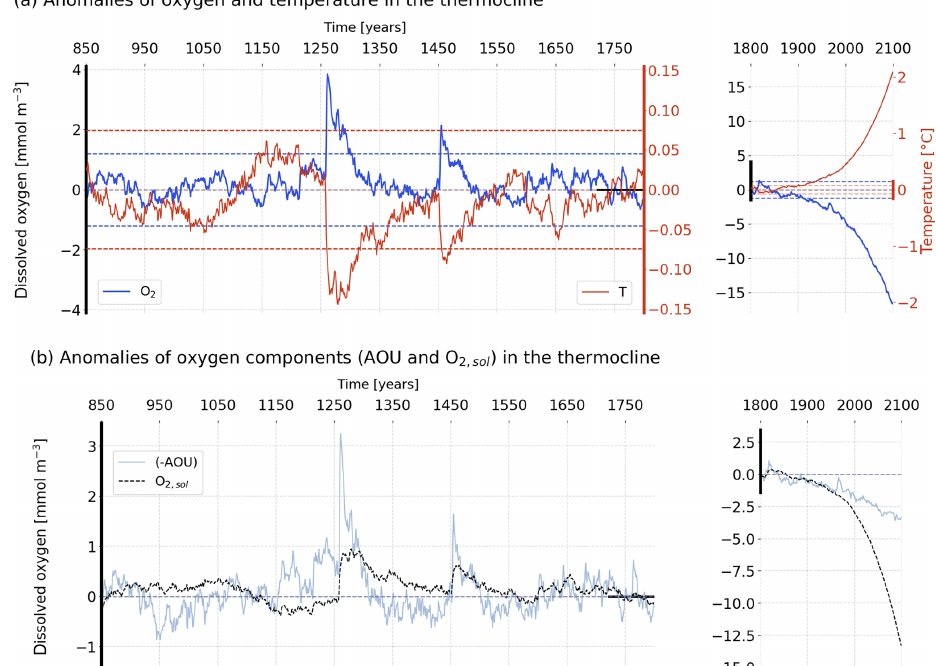
Figure 1. Temporal evolution of simulated anomalies in the thermocline (200–600m) (a) O 2 (dark blue) and T (red), and (b) − AOU (light blue) and the O 2 solubility component (dashed black) over the last millennium (left) and the historical and future periods (right). The horizontal dashed lines in panel (a) stand for the 2 standard deviation envelopes for O 2 (blue) and T (red) computed over the period 850–1800CE. The anomalies are relative to the pre-industrial reference period